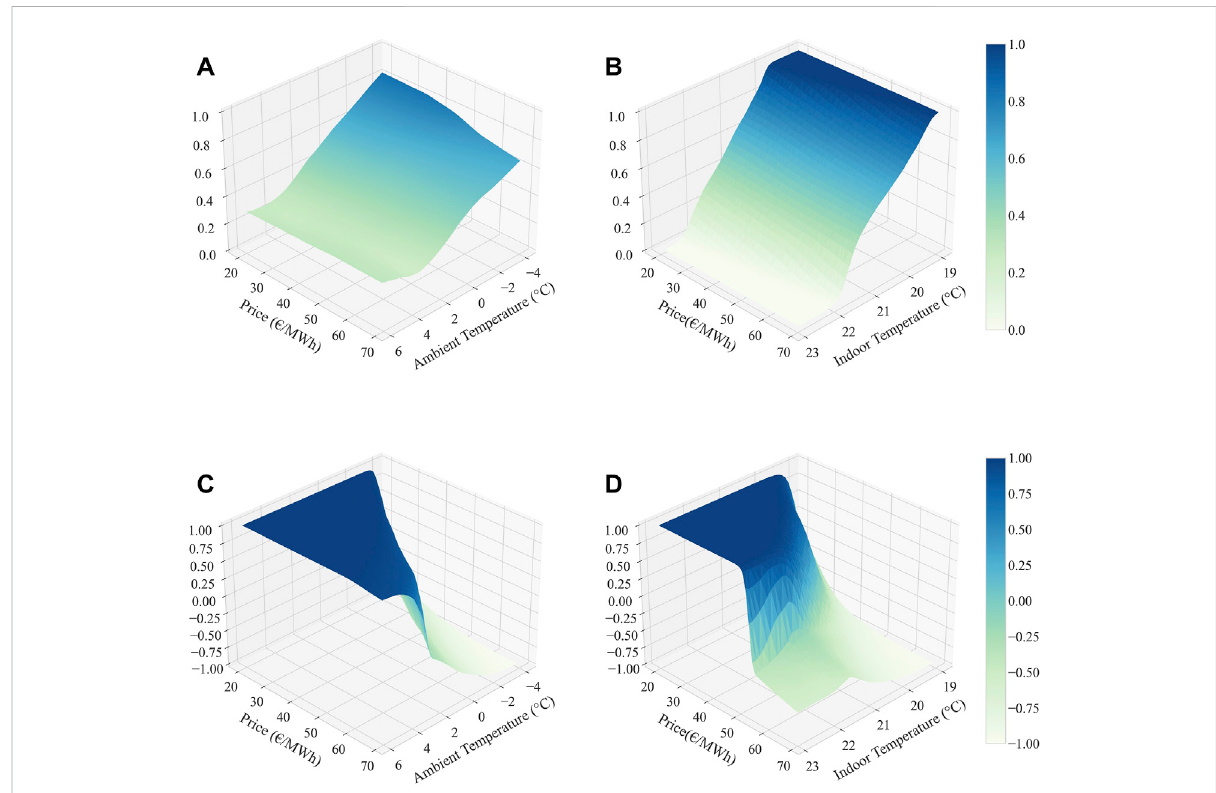
FIGURE 8 Control strategy of electric boiler and heat storage under (A/C) fi xed indoor temperature of 21 ° C and (B/D) fi xed ambient temperatures of 0 °